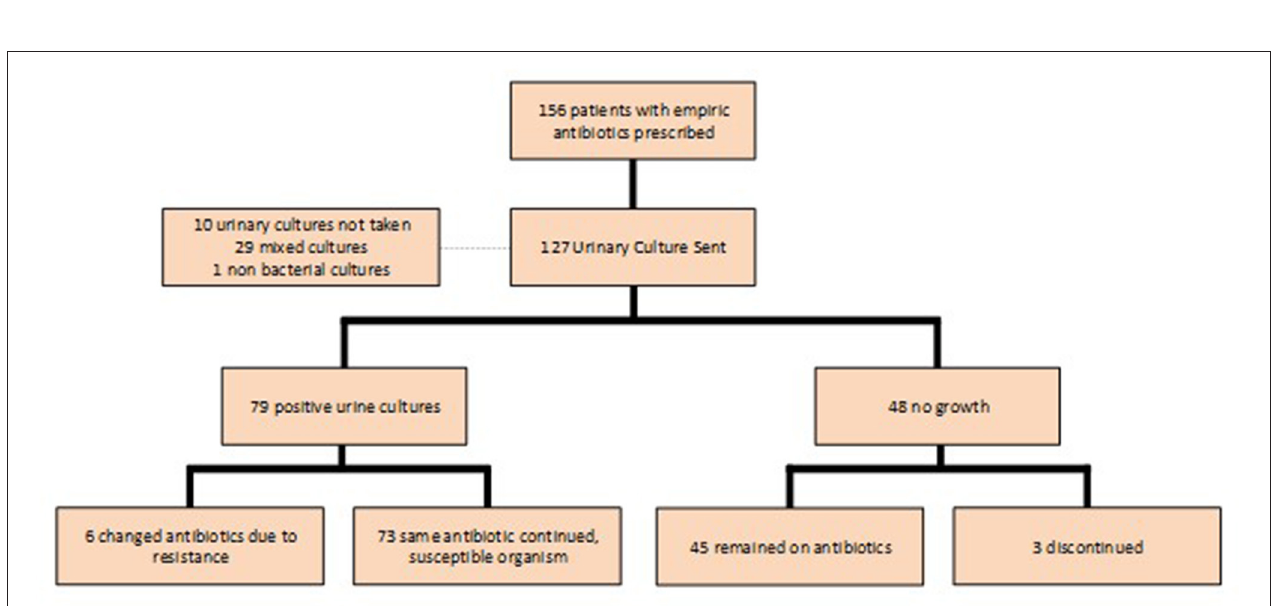
FIGURE 3 | Impact of urine culture result on prescribed treatment.